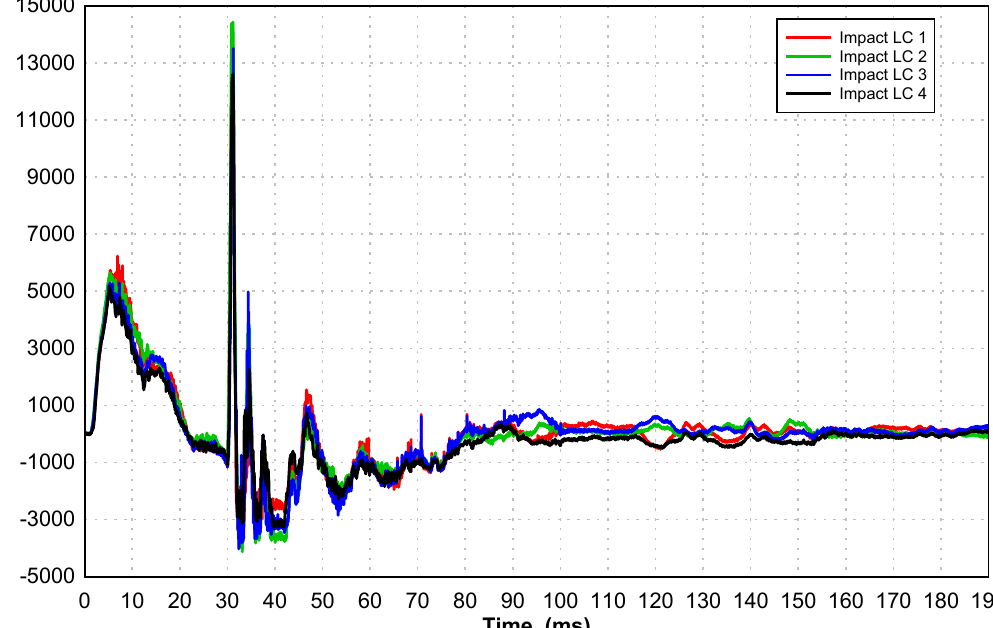
Figure 11. Individual impact load cell readings for CLT5-10